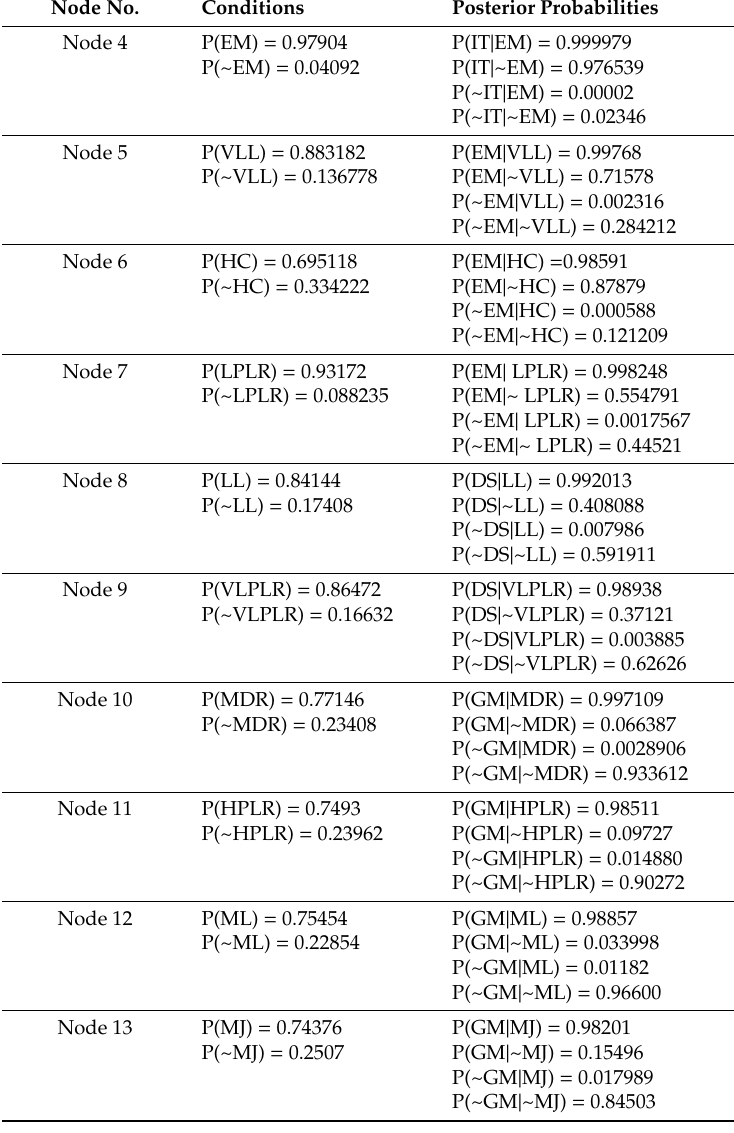
Table 3. Posterior probabilities for nodes